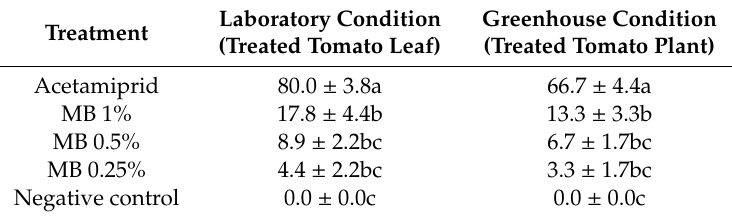
Table 1. Corrected cumulative percentage mortality of adults of Nesidiocoris tenuis exposed to methyl benzoate (MB) and acetamiprid (positive control) residues on tomato leaves (after 5 days in a laboratory test) or tomato plants (after 7 days in a greenhouse